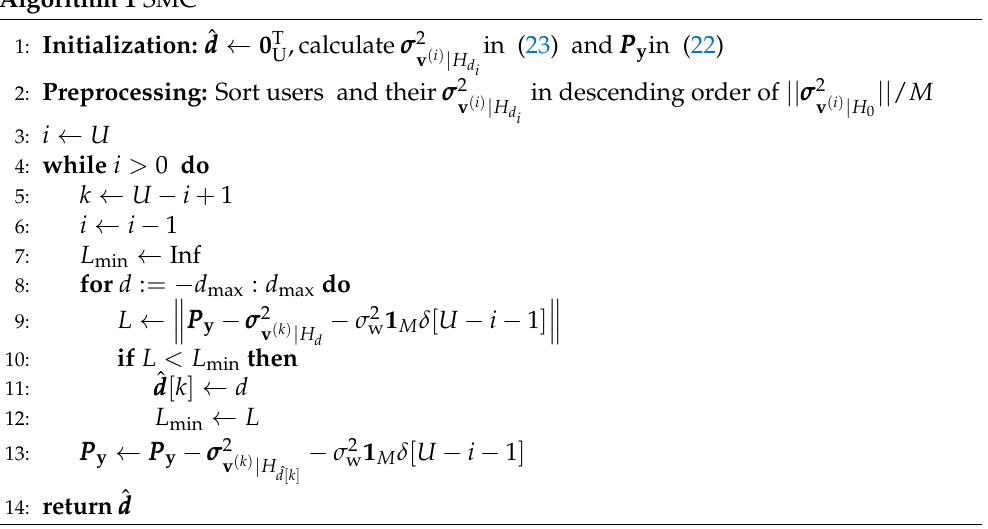
Algorithm 1. In Algorithm 1, δ [ · ] is the Kronecker delta